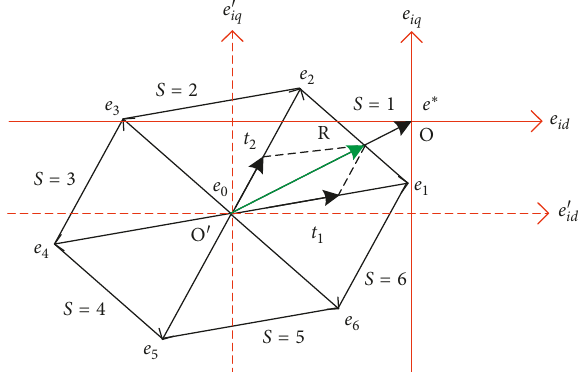
Figure 6: Predicted current error space vector diagram.